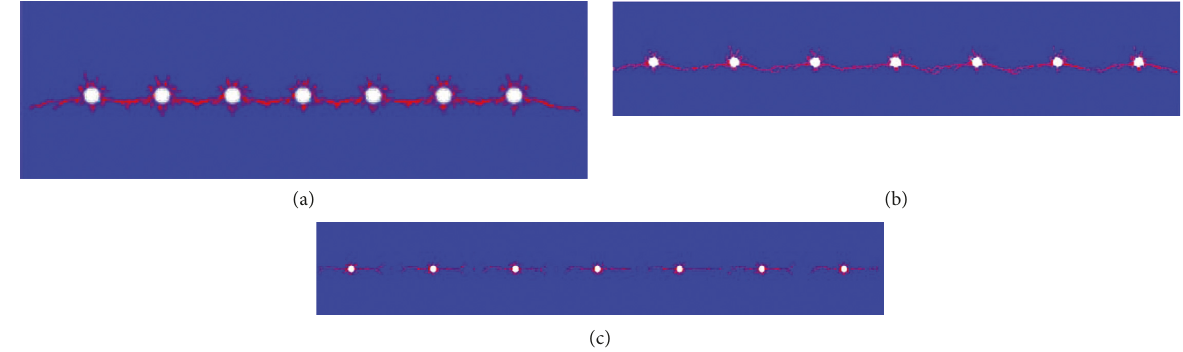
Figure 13: The presplitting blasting borehole spacing of (a) 400mm, (b) 500mm, and (c) 600